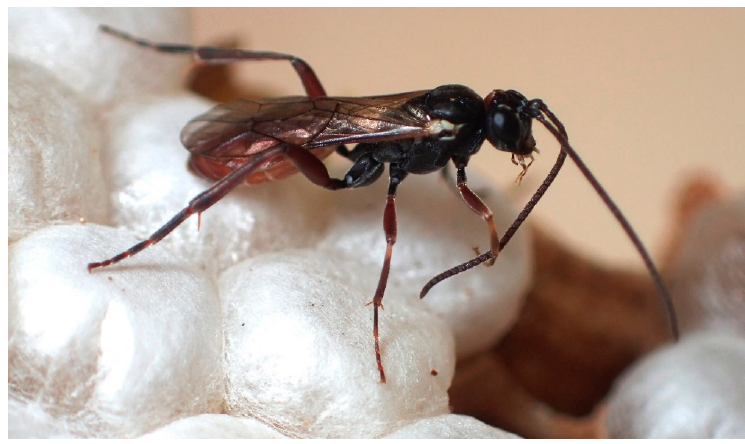
Figure 1. Adult female of Sphecophaga vesparum . Credit: Robert L. Brown.